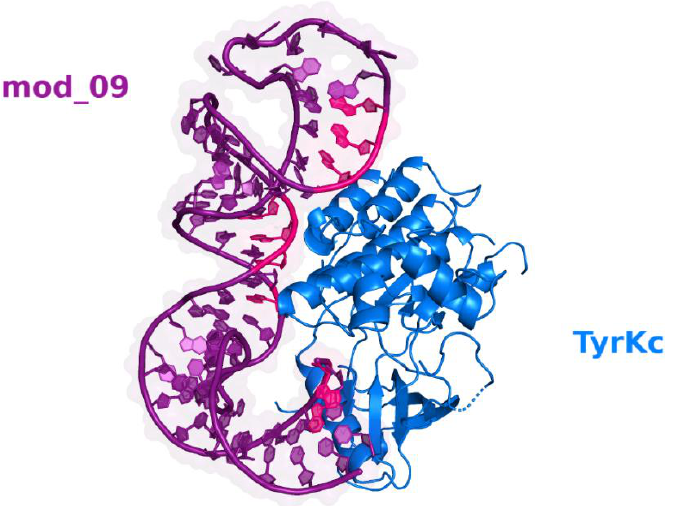
Figure 3. Cartoon view of the interaction showing the binding interfaces (pink) between the aptamer (purple) and the TyrKc domain (blue).